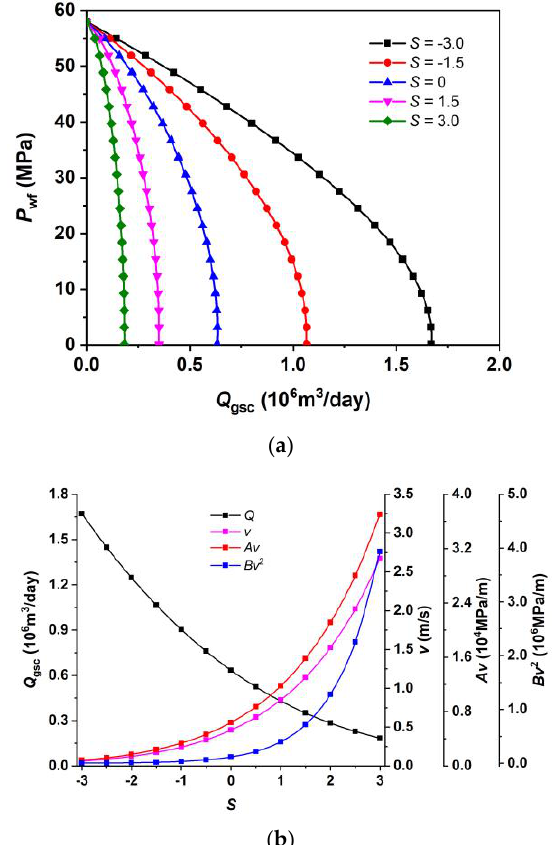
Figure 11. Effect of skin factor on gas production rate and flow characteristics. ( a ) IPR curves with different skin factors. ( b ) Characteristic analysis of flow regime at the well bottom hole.